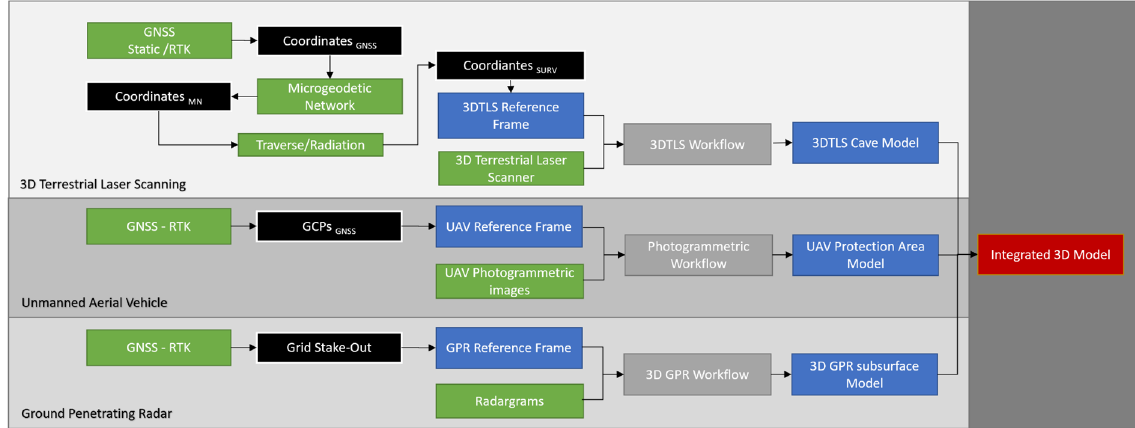
Figure 3. General workflow scheme followed in this study.